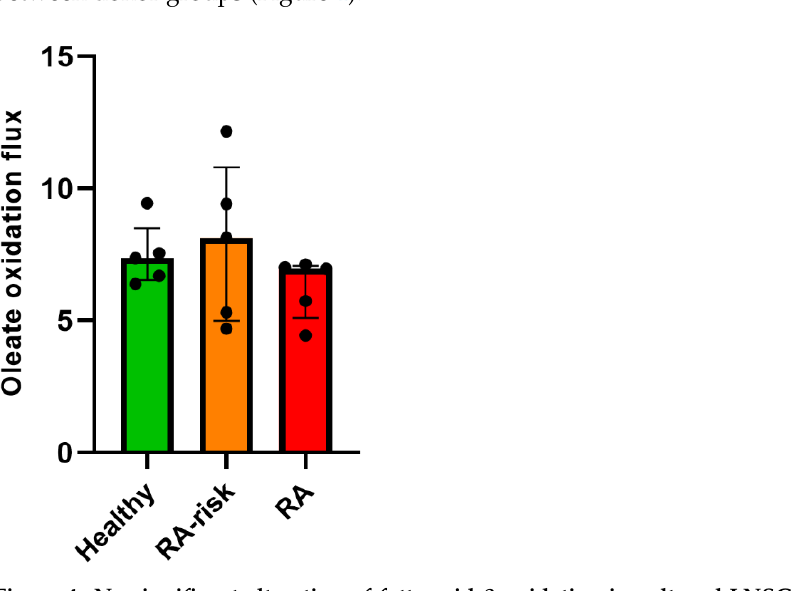
Figure 4. No significant alteration of fatty acid β -oxidation in cultured LNSCs. Specific activity (SA) of the oleate flux through the mitochondrial β -oxidation system in nmol per hour per mg protein. All donors passage 3, n = 5 per group and three technical replicates per condition, mean value of three replicates is displayed. Data are presented as median + interquartile range. Statistical differences were determined using two-way ANOVA + Dunnett’s T3 multiple comparisons test.